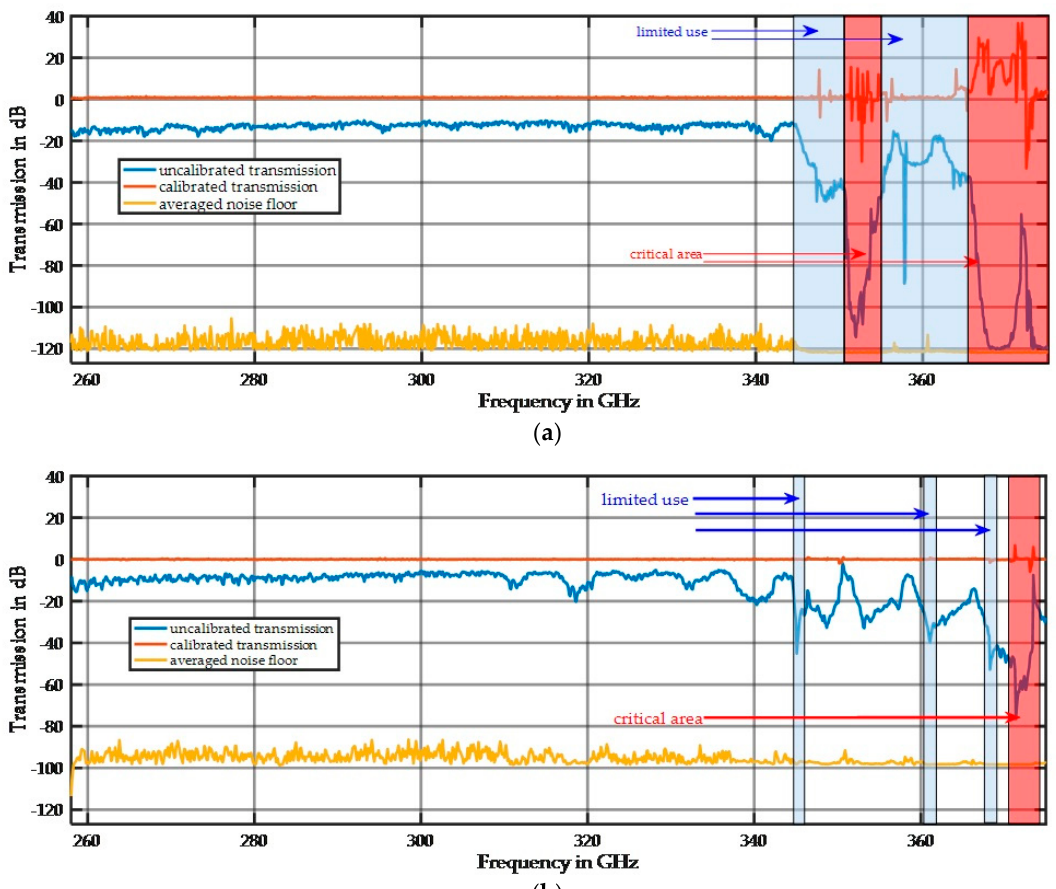
Figure 4. ( a ) Plot showing the spectral behavior of setup 1 without a sample. The blue regions indicate frequency ranges with limitations; these ranges can only be used with adequate signal amplitudes. The red regions have highly restricted use; ( b ) Plot showing the spectral behavior of setup 2 without a sample.